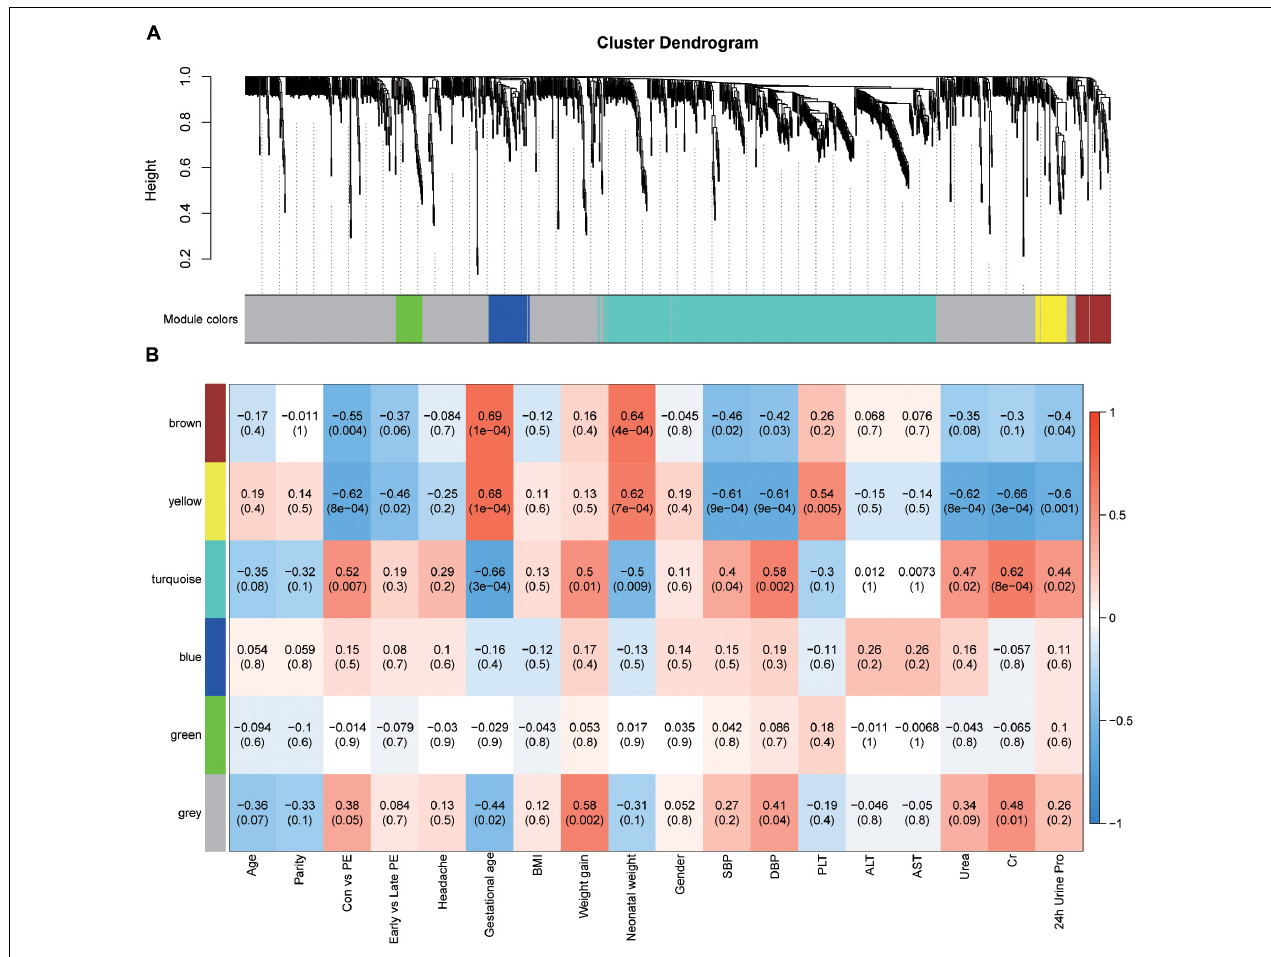
FIGURE 2 | Identification of modules associated with the clinical traits of preeclampsia. (A) Dendrogram of all detected metabolites clustered based on the measurement of dissimilarity (1-TOM). The color band shows the results obtained from the automatic single-block analysis. (B) Heatmap of the correlation between the module eigengenes and clinical traits. Each row corresponds to a module eigenpeptide, column to a trait, respectively. Each cell contains the corresponding correlation and p -value. The table is color-coded by correlation according to the color